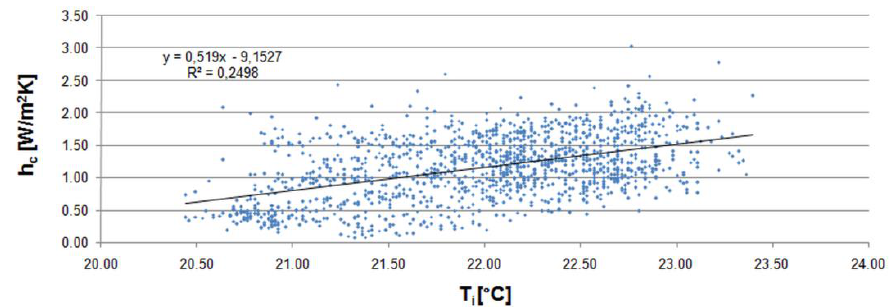
Figure 9. Convective heat transfer coefficient versus indoor air temperature.